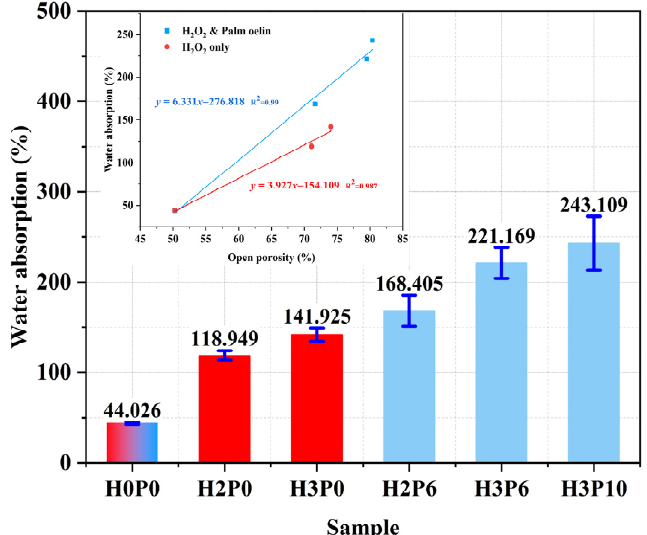
Figure 18. Water absorption of matrix and geopolymer foams.